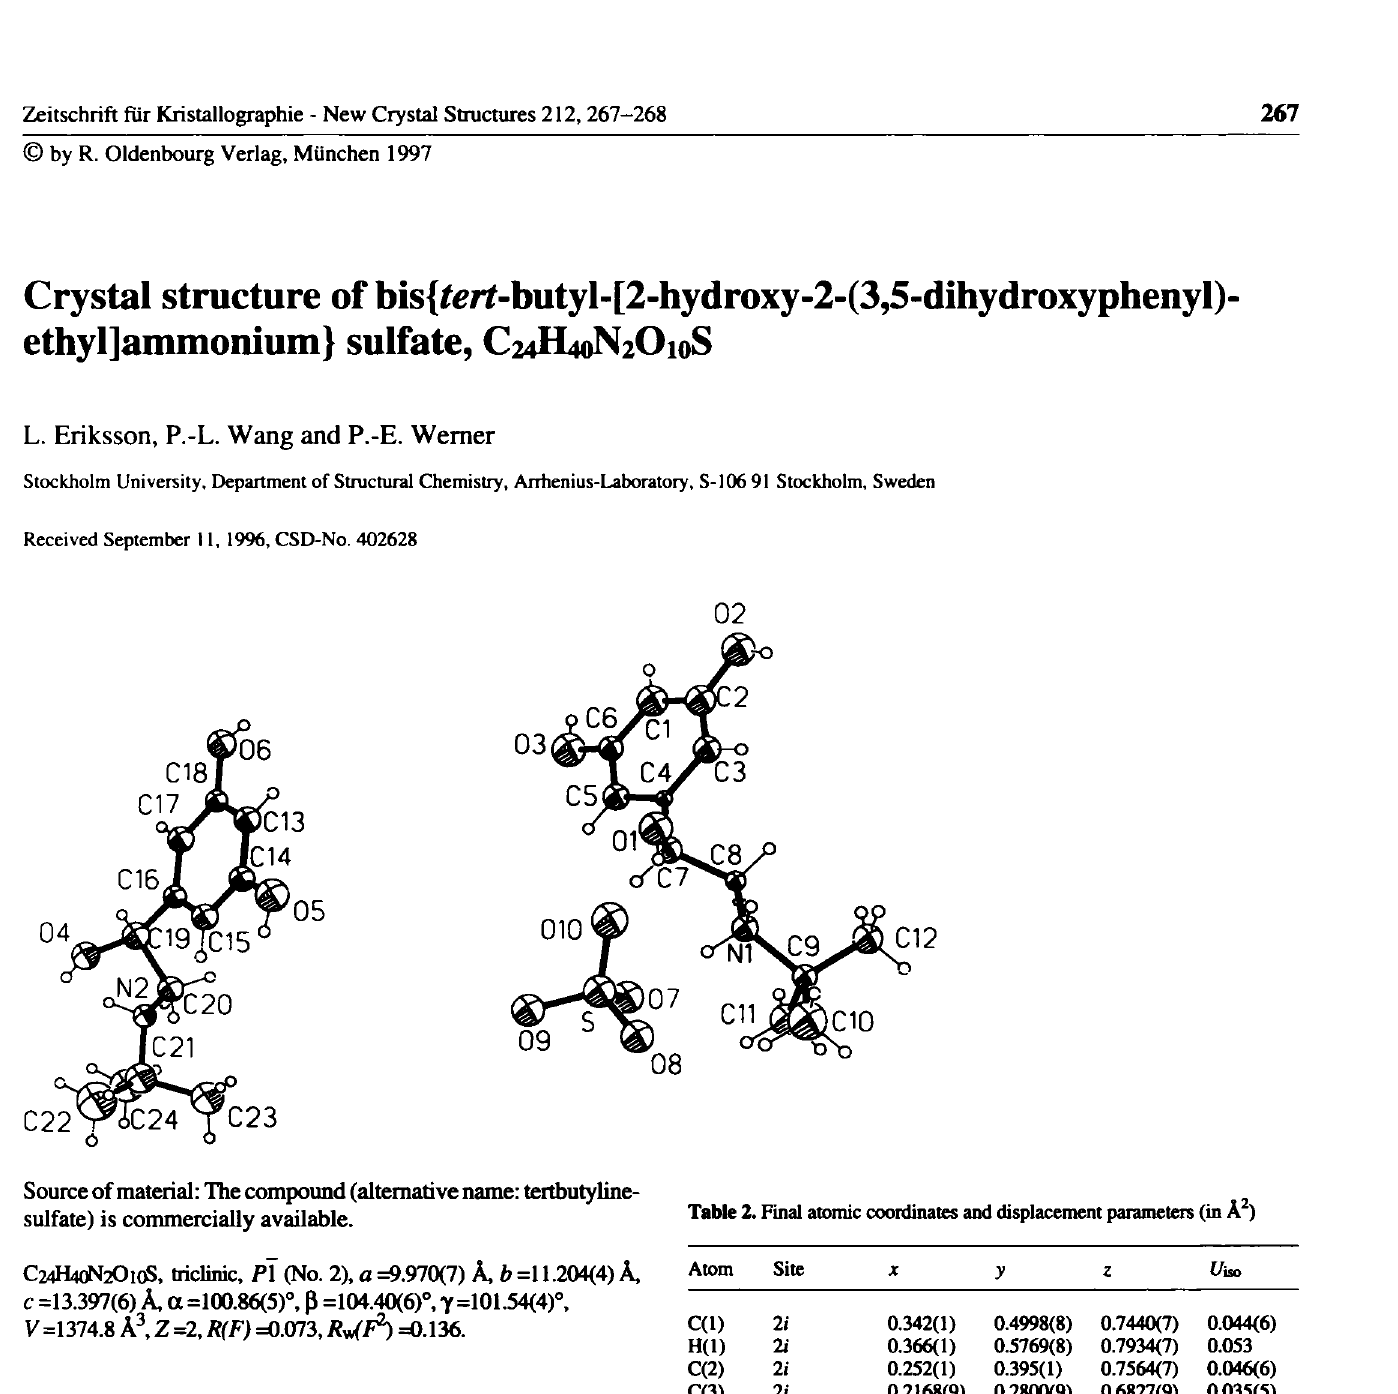
Table 2 · Füial atomic "»^nates a« 1 displacement parameters (in A )